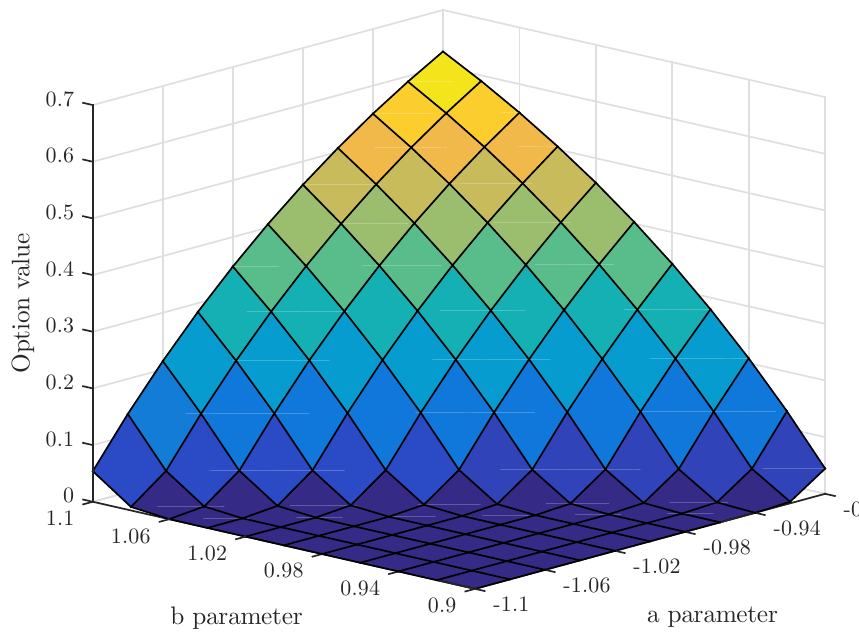
Figure 6. π -option price estimations for varying a and b —Microsoft Corporation stock.